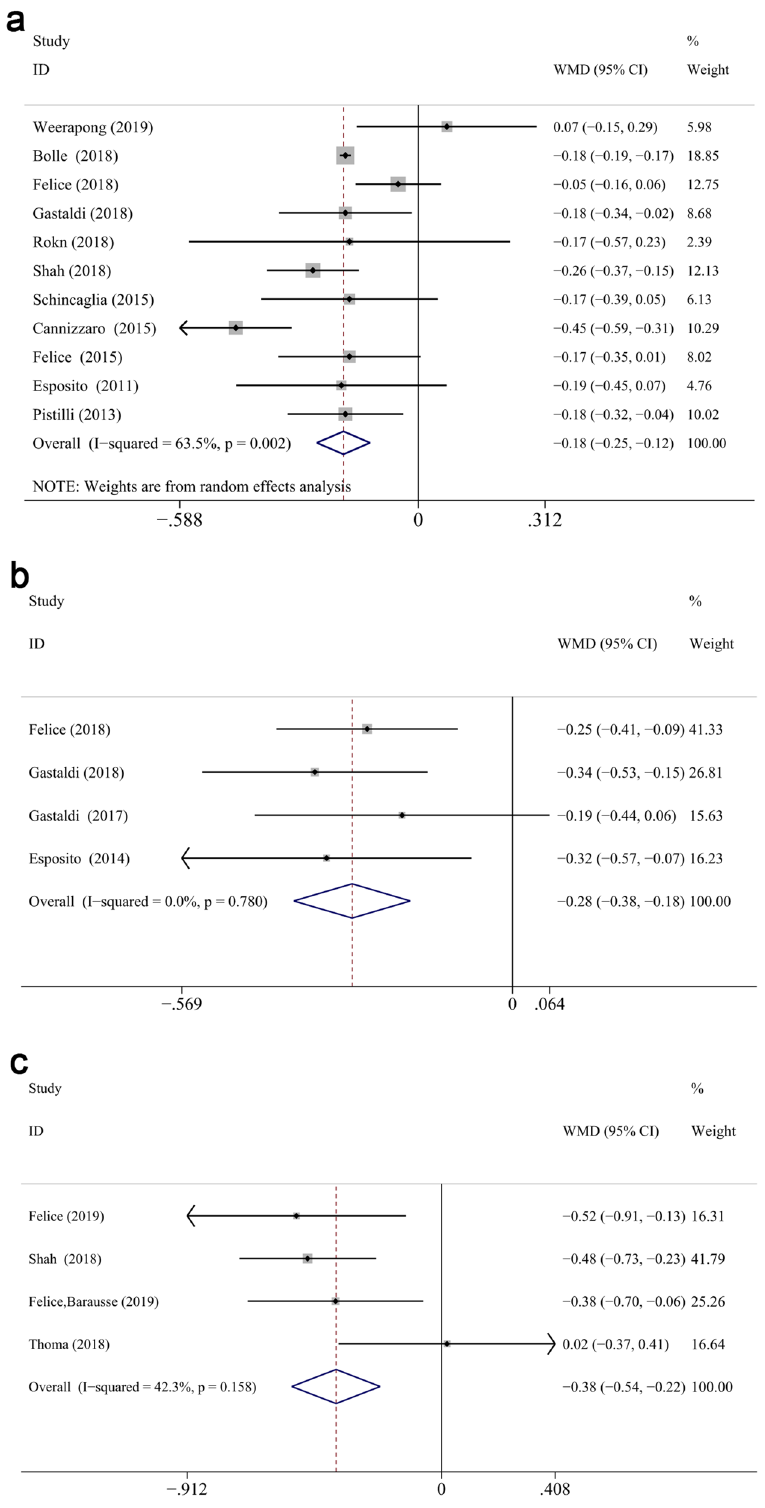
Figure 7. Forest plots (Difference in means) for marginal bone loss, with baseline at implant placement, comparing extra-short and longer implant groups at 1 ( a ), 3 ( b ) and 5 ( c ) years. Negative value in difference in means indicates more MBL in the longer implant